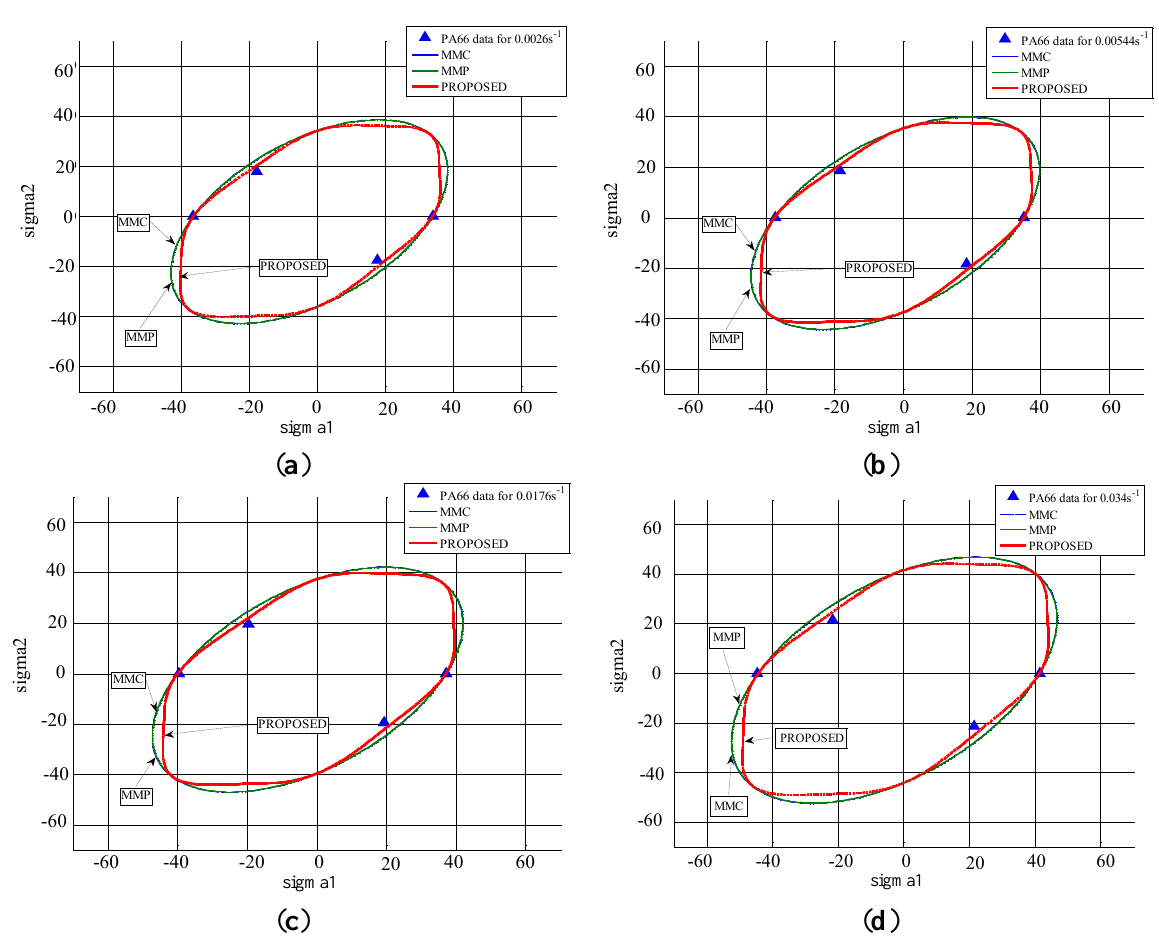
Figure 16. Predicted yield stress using different criteria and experimental results of PC represented in the principal stress plane (σ